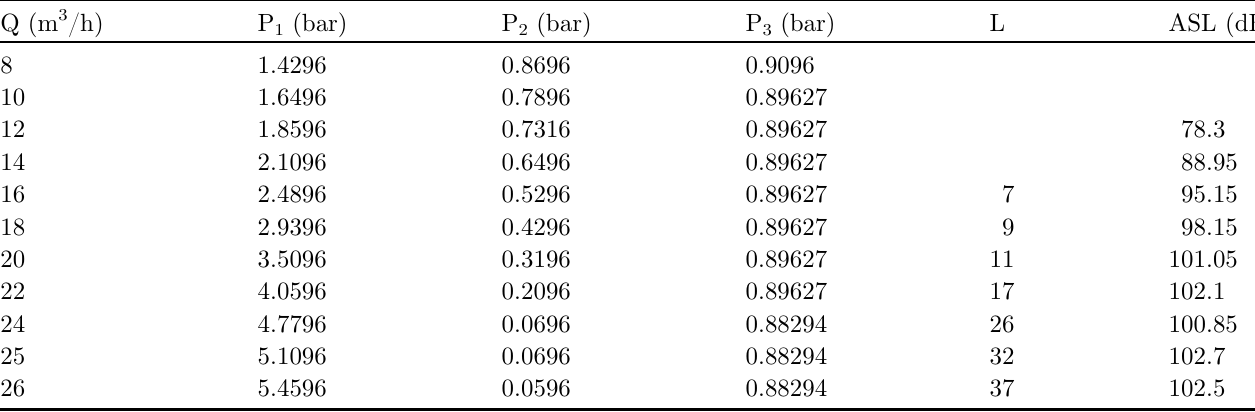
Table 3. The experimental results for the single-hole ori fi ce with EDR = 0.4.